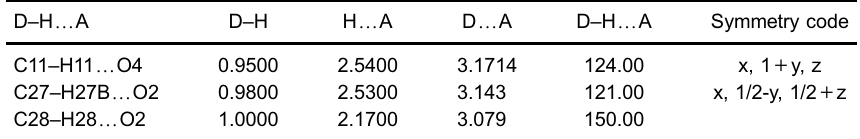
Table 2. Hydrogen bonds information (Angstrom, Deg).